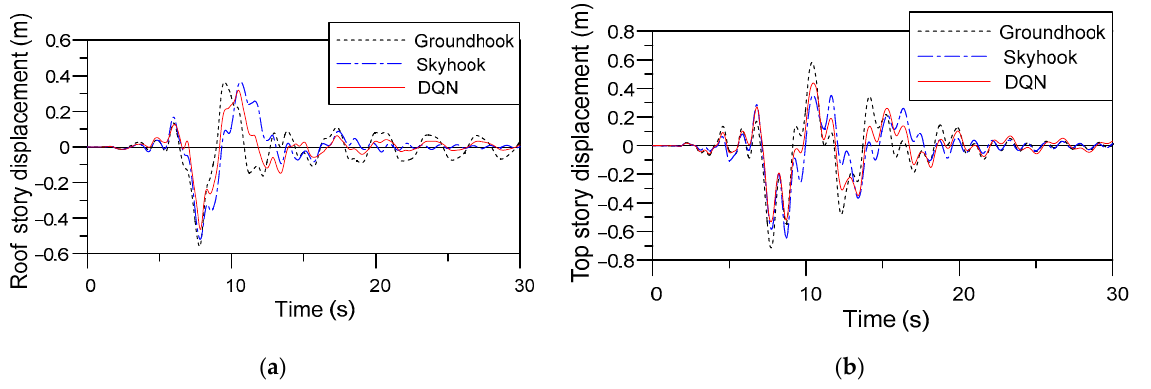
Figure 15. Comparison of the roof story displacement time histories: ( a ) responses to EV1, ( b ) responses to EV2.